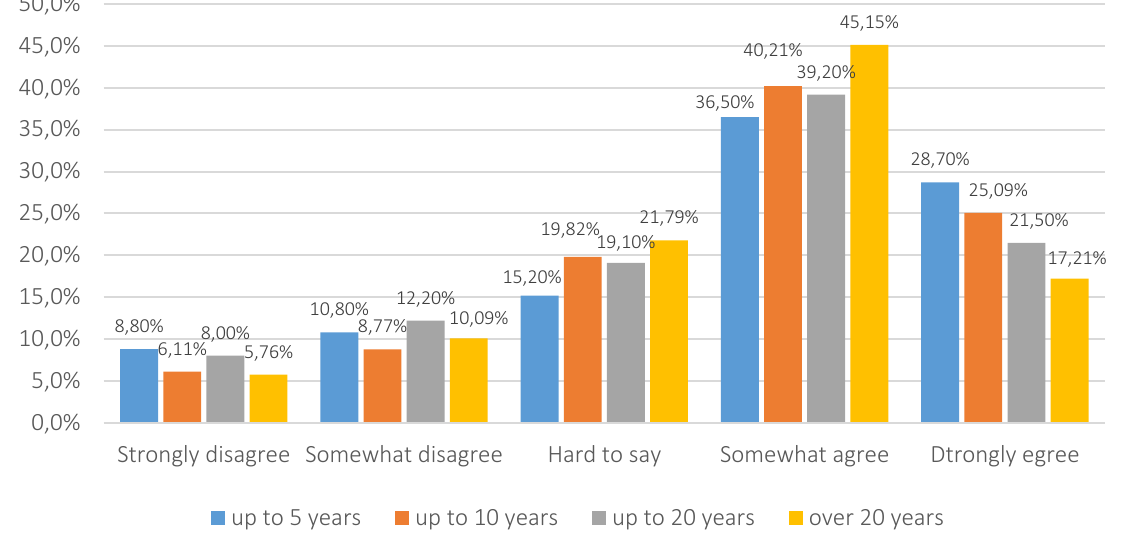
Figure 6. The quality of interpersonal relationships at work vs. a respondent’s length of